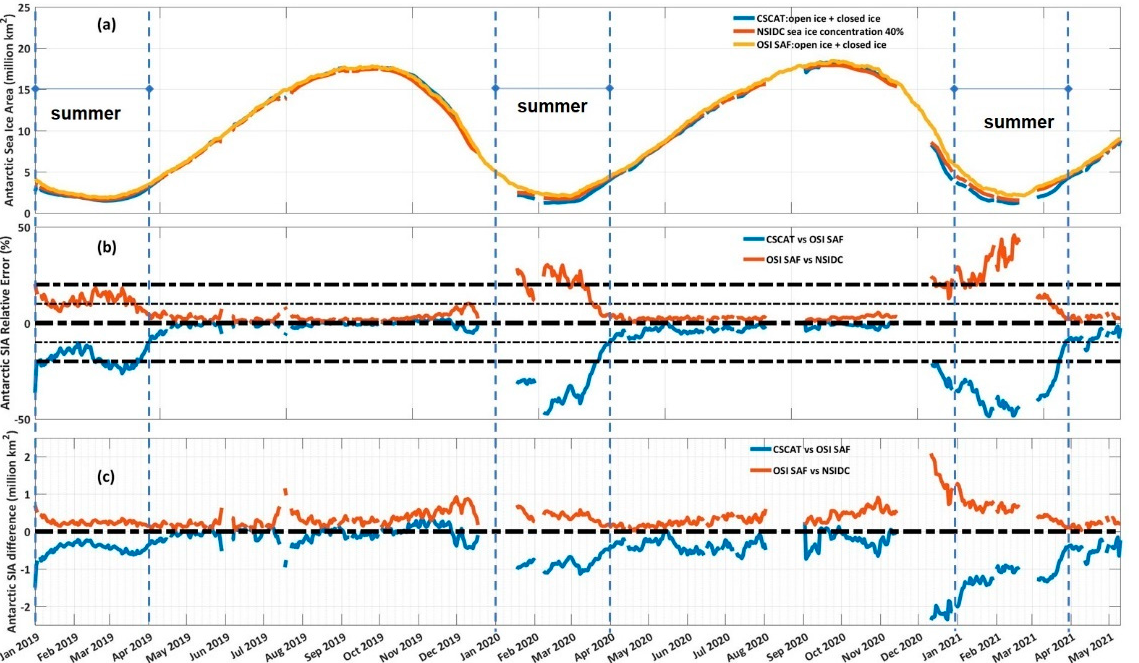
Figure 13. The Antarctic results from 1 January 2019 through 10 May 2021 ( a ) daily sea ice area for CSCAT (blue line), NSIDC 40% ice extent (red line), and OSI SAF sea ice edge product (yellow line), respectively, ( b ) sea ice area relative error, and ( c ) sea ice area difference between CSCAT and OSI SAF sea ice edge product (blue line), between OSI SAF sea ice edge product and NSIDC 40% ice extent (red line), respectively.